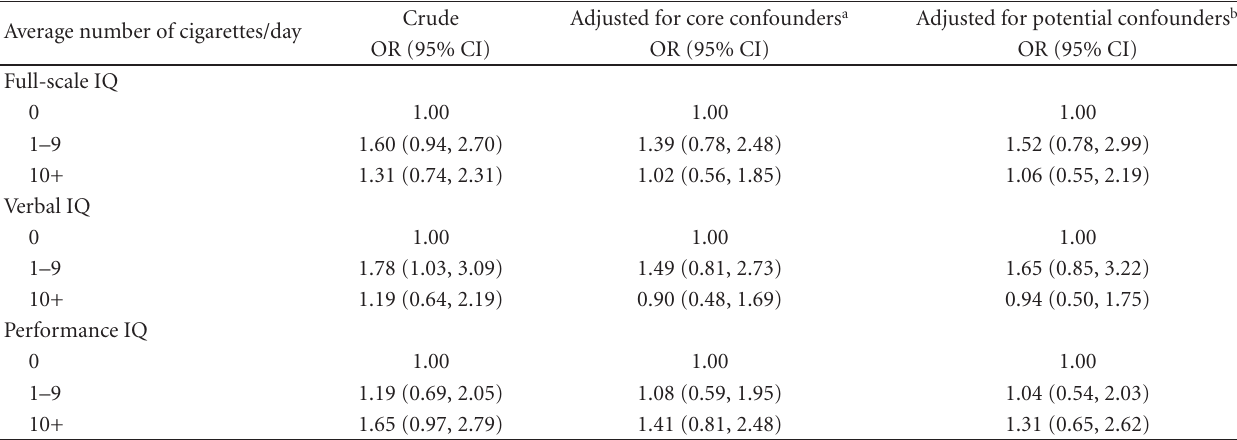
Table 3: Maternal smoking in pregnancy and the risk of low